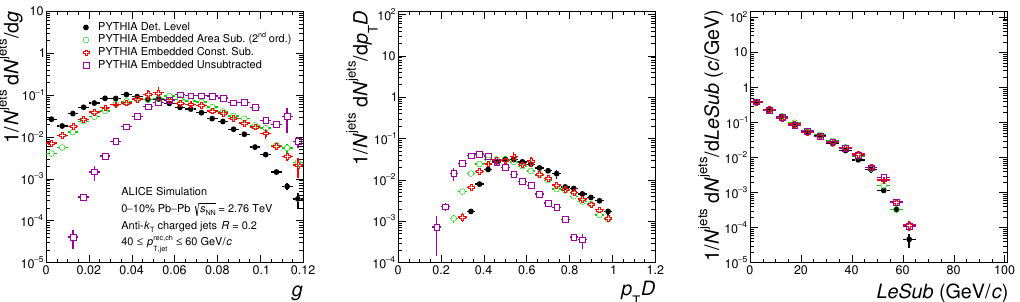
Figure 3 . Background subtraction performance for jet shapes studied with jets from PYTHIA events embedded into real Pb-Pb events, in the background subtracted transverse momentum in- terval 40 (cid:20) p rec ; ch (cid:20) 60 GeV/ c for the area derivatives and constituent subtraction T ; jet